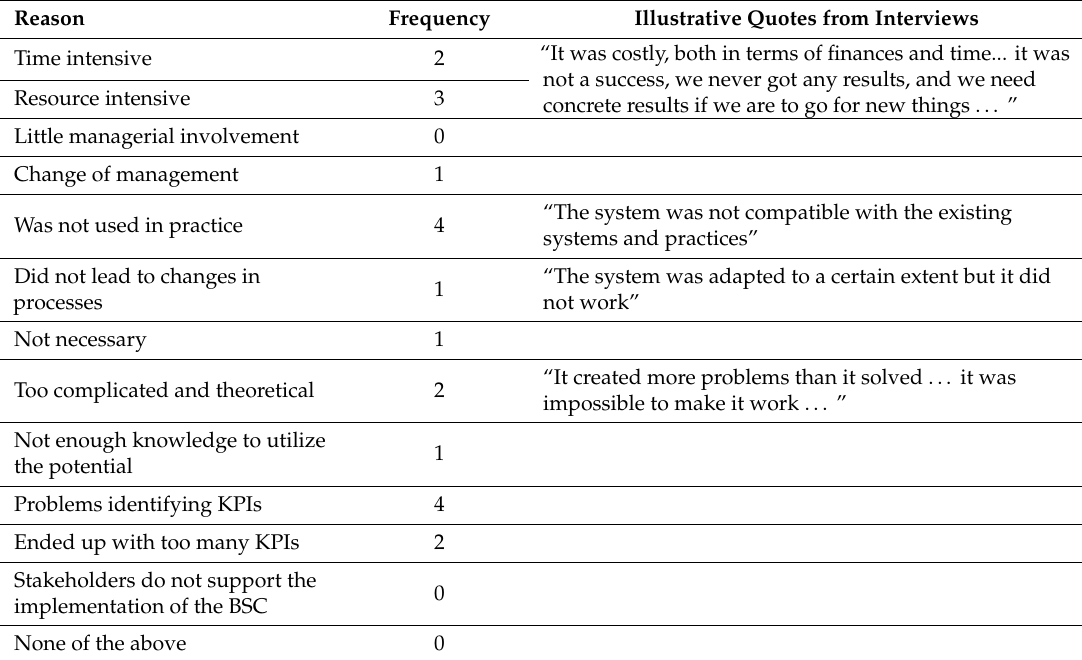
Table 27. Reasons why the BSC was discarded (N =